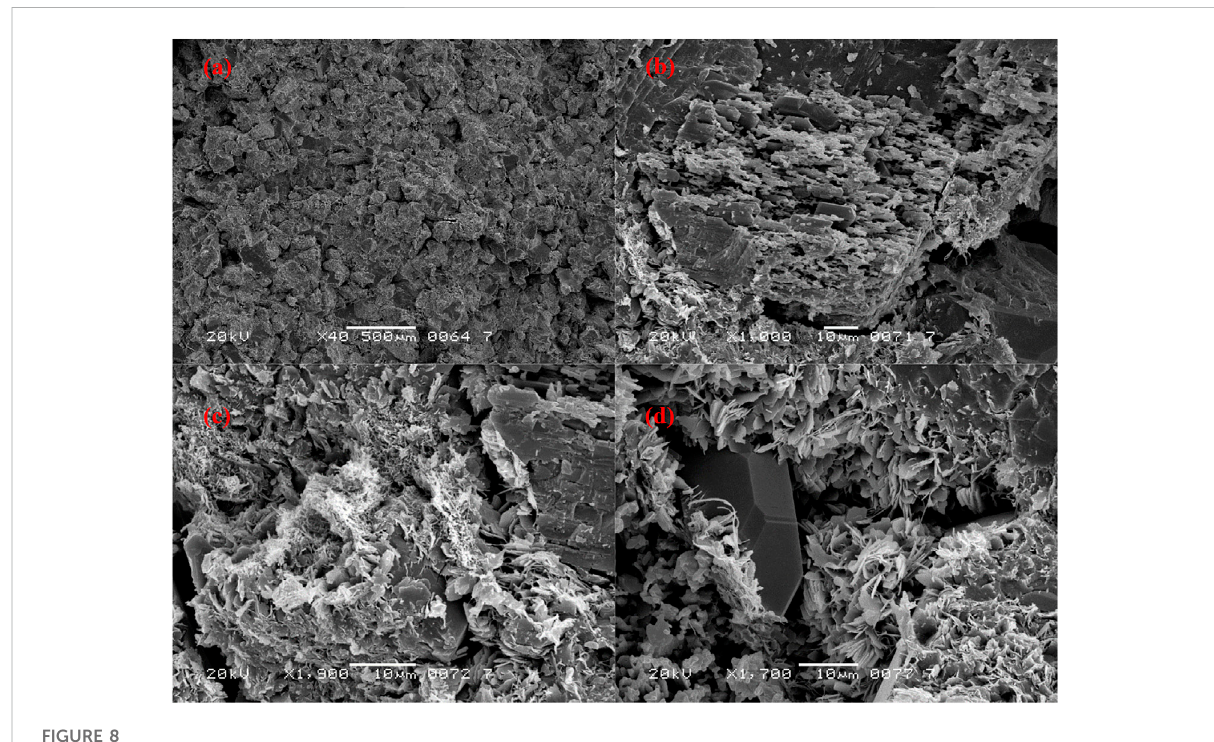
FIGURE 8 SEM image of core 11 of Zhoufu 59 – 51